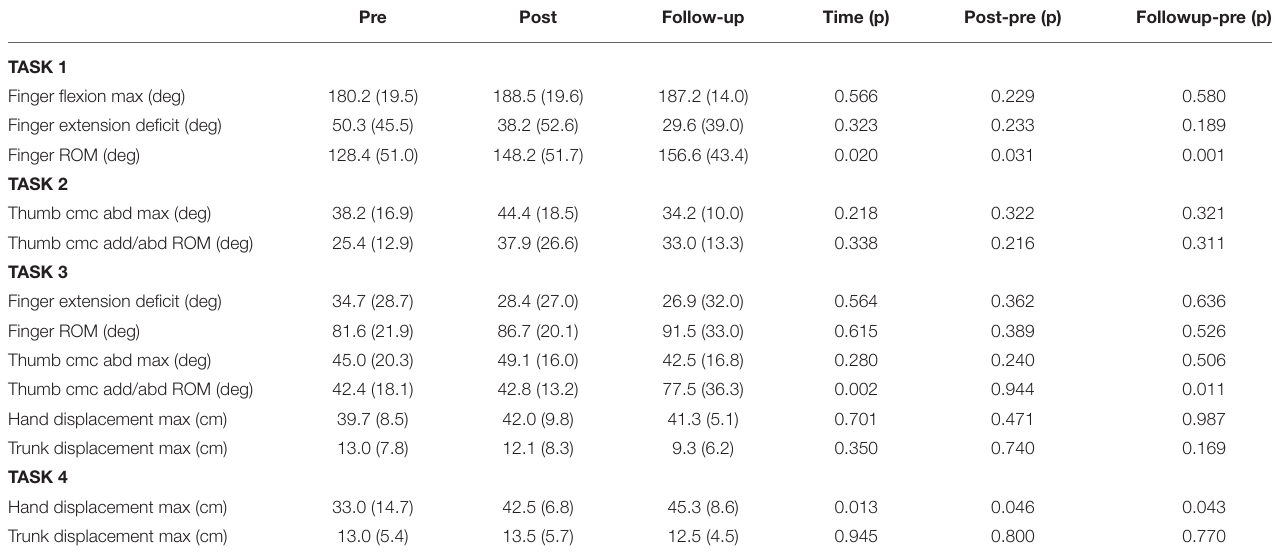
TABLE 5 | Summary of biomechanics data: mean (SD). Pre Post Follow-up Time (p) Post-pre (p) Followup-pre